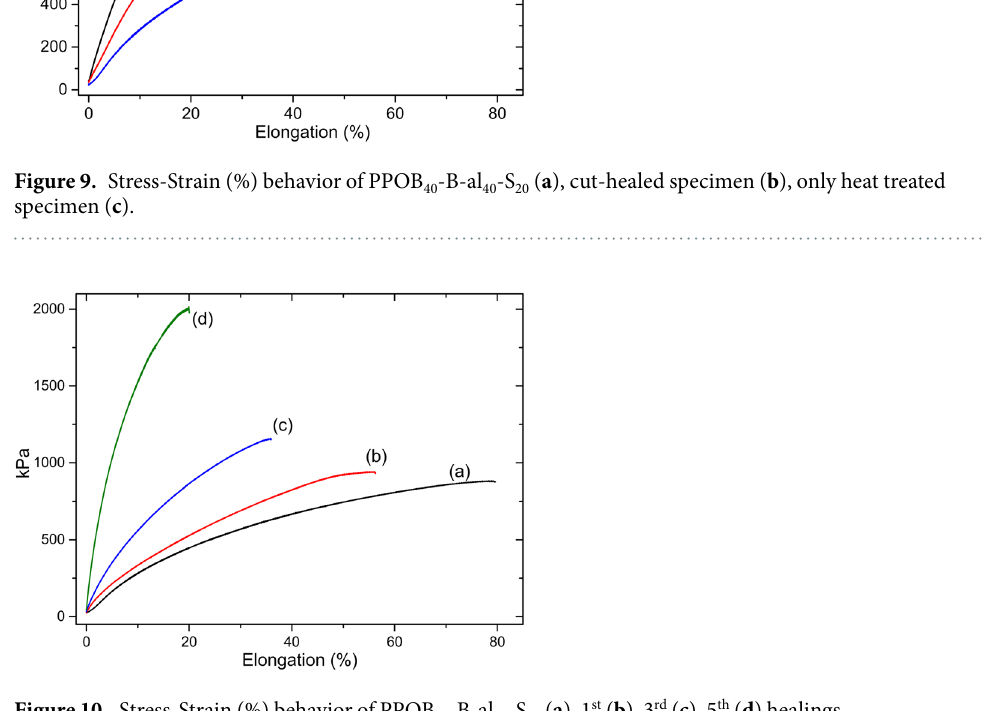
Figure S6. According to TGA data, the thermal stability of PPOB 40 -B-al 40 -S 20 film gradually enhances towards the 5 th healing cycle both in terms of initial degradations and char yields. As can be seen, the PPOB 40 -B-al 40 -S 20